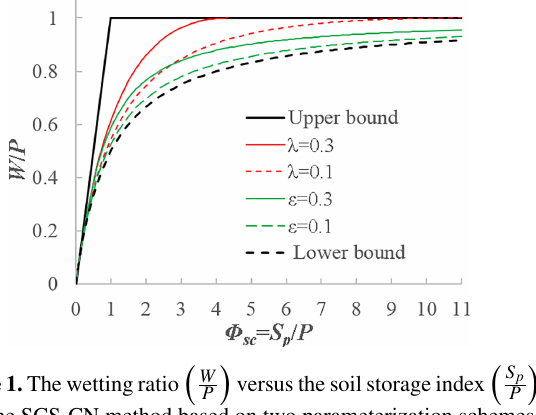
Figure 1. The wetting ratio from the SCS-CN method based on two parameterization schemes: λ = W i (scheme 1) and ε = W i S p − W i